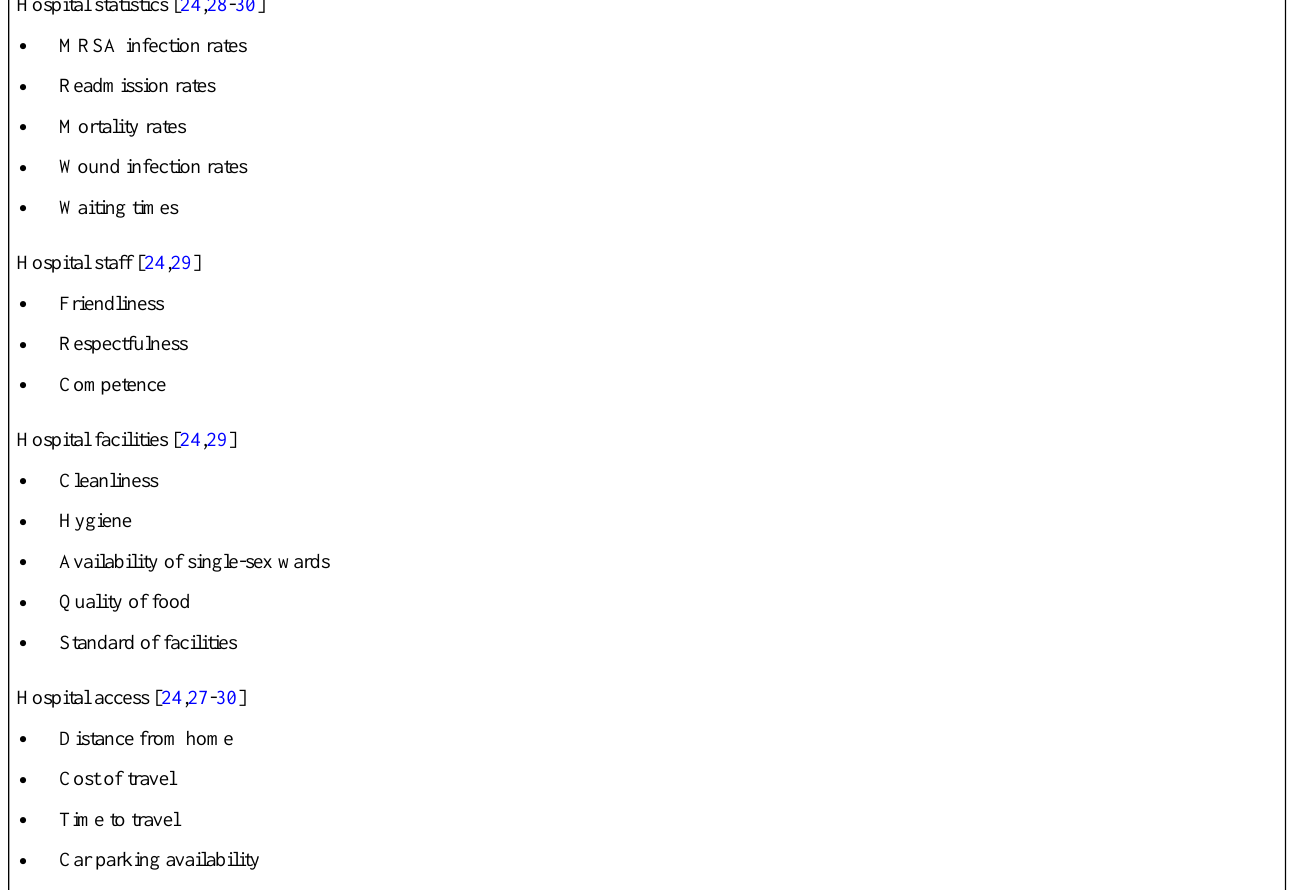
Textbox 2. Quality indicators identified by the literature